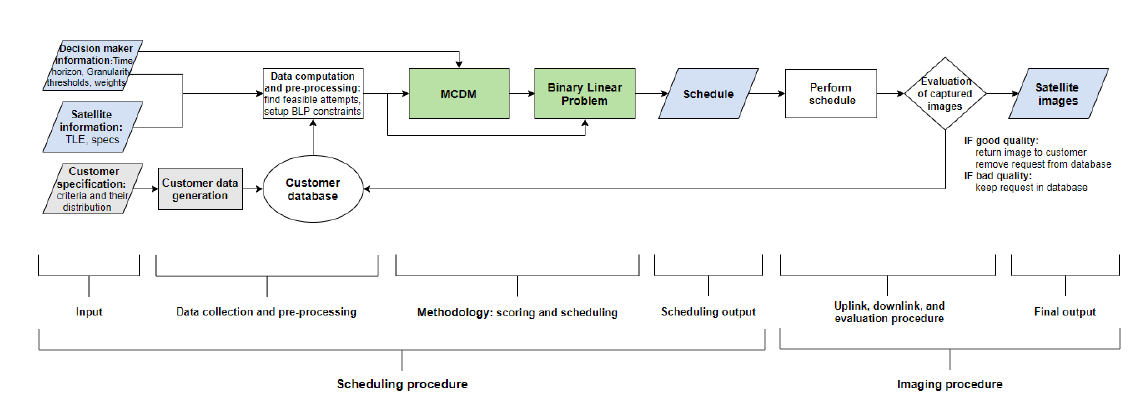
Figure 1. Holistic illustration of the overall solution approach for the Satellite Image Acquisition Scheduling Problem (SIASP). The data generation variables and data generation process are only required in the case of not having any data. Note that the schedule generated in the scheduling procedure is not modified by the operators prior to up-link. This is not the case in the